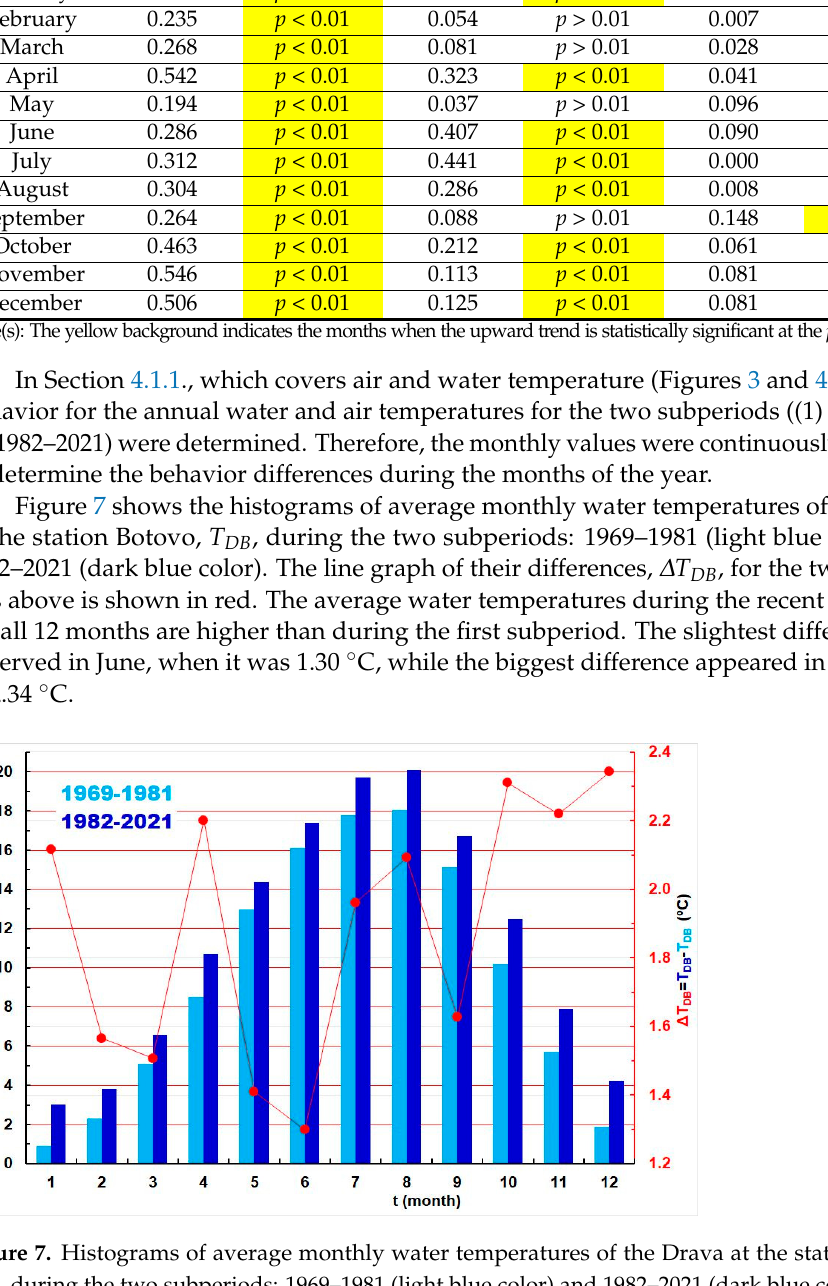
Figure 8. Histograms of average monthly air temperatures in Varaždin, T V , during the two subperi- ods: 1969–1981 (light green color) and 1982–2021 (dark green color). A line graph of their differences, Δ T V , during the two subperiods above is shown in red. Figure 9 shows the histograms of the average monthly differences in the water tem- perature of the Drava at the station Botovo, T DB , and the air temperature at Varaždin, T V , Δ T = T DB − T V , during the two subperiods: 1969–1981 (grey color) and 1982–2021 (black). A line graph of their differences, ΔΔ T , during the two subperiods above is shown in red. This analysis indicates the regularity of the behavior of the differences, ΔΔ T . In the first